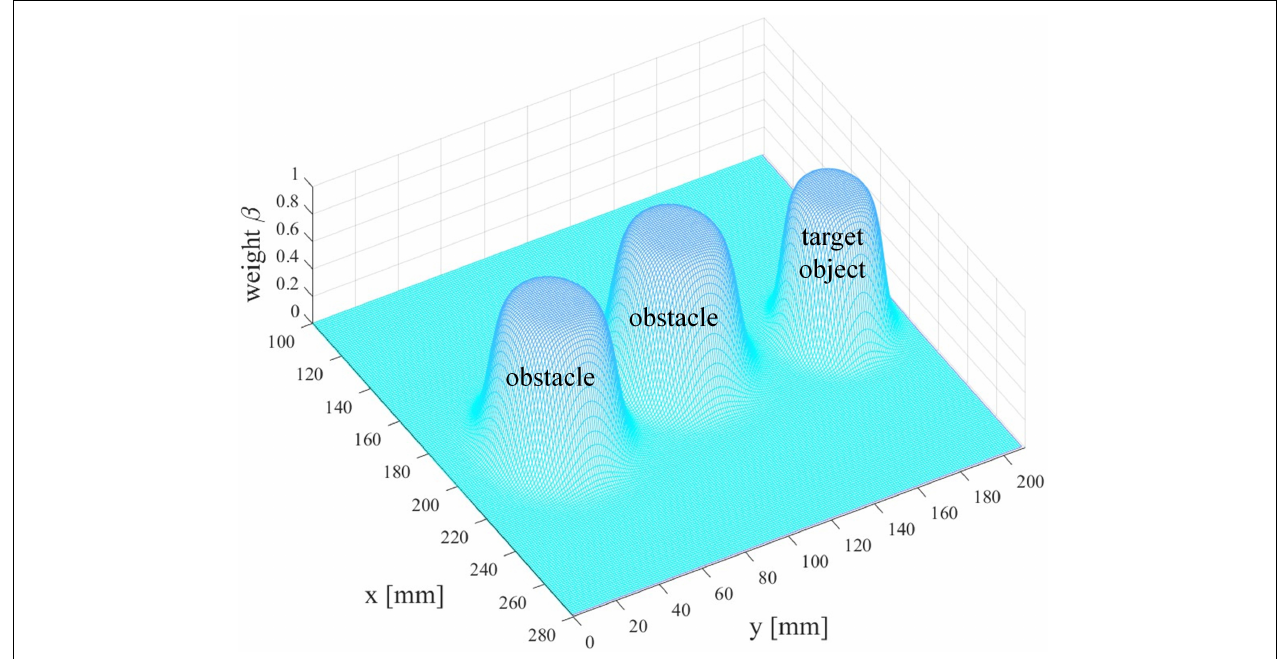
FIGURE 7 | The distribution of the arbitration factor β